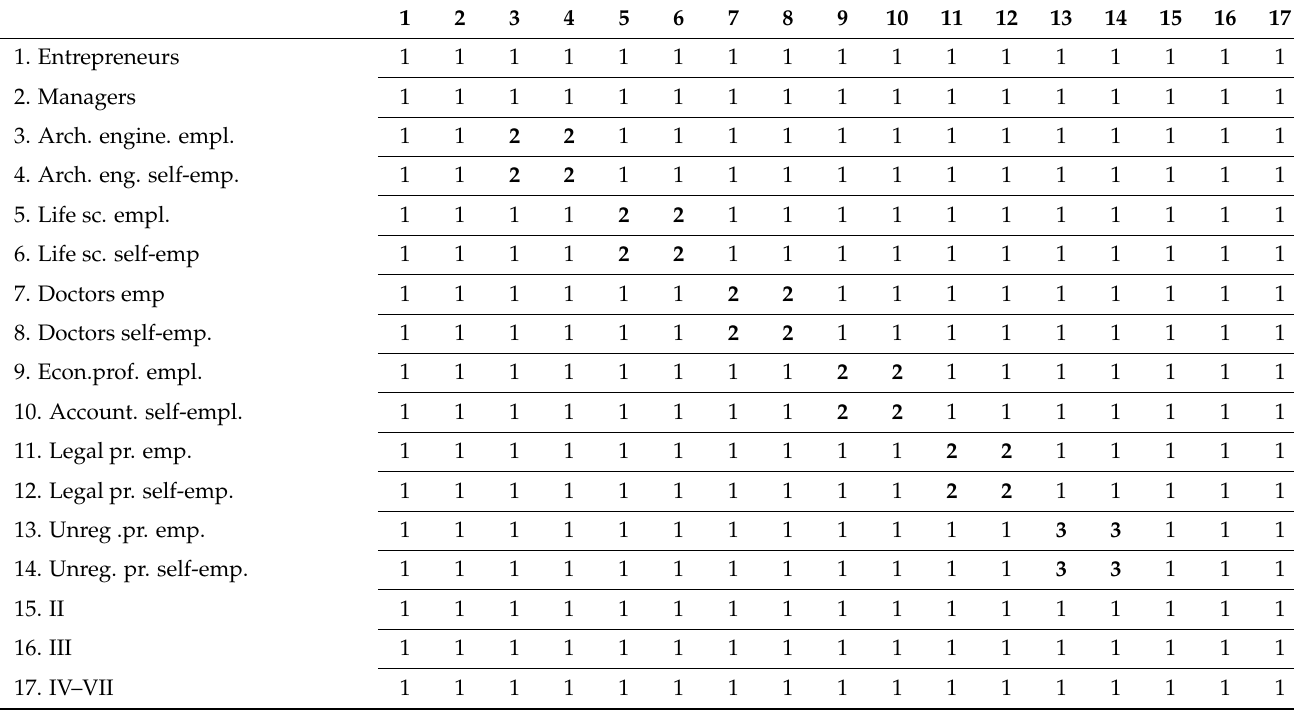
Table A4. Regulated and unregulated professionals—Model 4a and 4b.